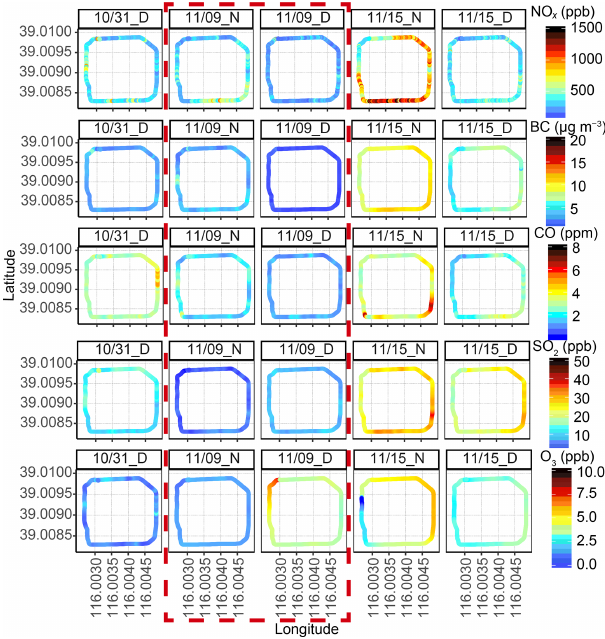
Figure 5. The spatial distributions of NO x , BC, CO, SO 2 , and O 3 observed around the 4th Ring Road of Beijing. The data from 31 October, 9 November and 15 November 2014 were selected to represent the pre-APEC, full-APEC, and post-APEC periods, re- spectively. The subtitle for each circuit indicates the observation time in the form “MM/DD_Day, Night”. The dotted red rectangle area indicates the full-APEC